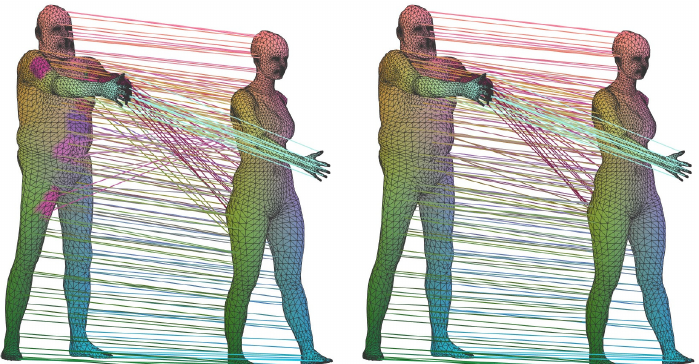
Figure 25. The figure shows exemplary point-to-point maps from one human body model to another. The overall performance of the proposed geometric method (right) is working better than the compared SHOT(left) method on the entire shape [83]. Republished with permission of ACM, from ACM Trans. Graph., E. Corman and M. Ovsjanikov, Vol. 38, 2019; permission conveyed through Copyright Clearance Center, Inc.